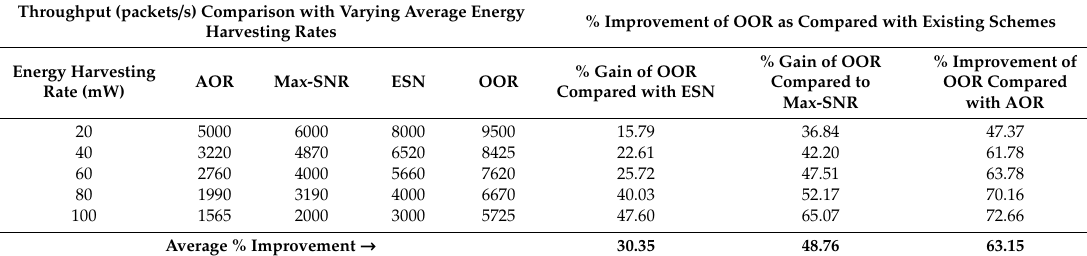
Table 6. Descriptive observations of OOR performance in terms of throughput (second